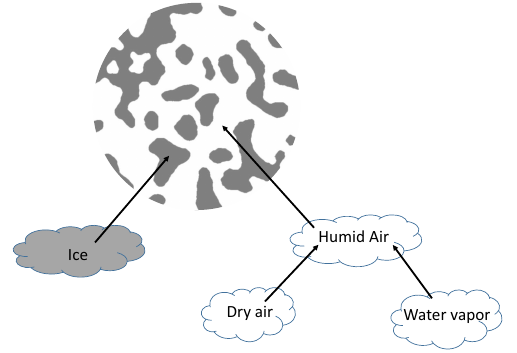
Figure 1. Schematic showing a continuum point of snow with the associated constituents for a mixture theory